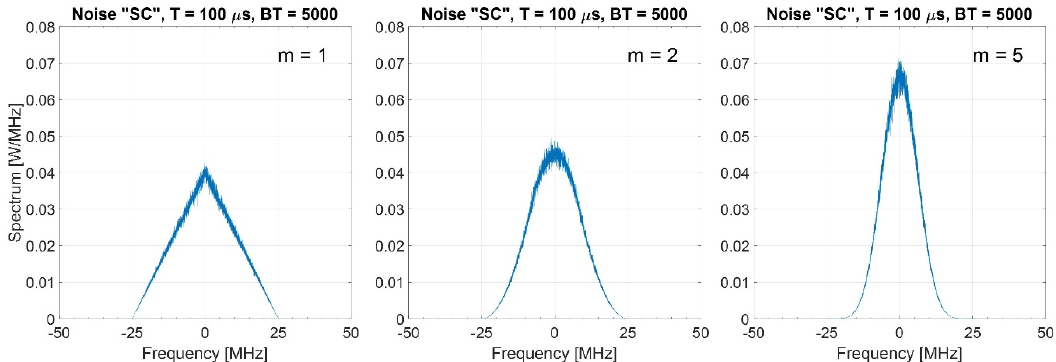
Figure 8. Spectrum of the “SC” noise waveforms (estimated on 1000 trials), BT = 5000, m = 1, 2, 5. Sensors 2020, 20, x FOR PEER REVIEW